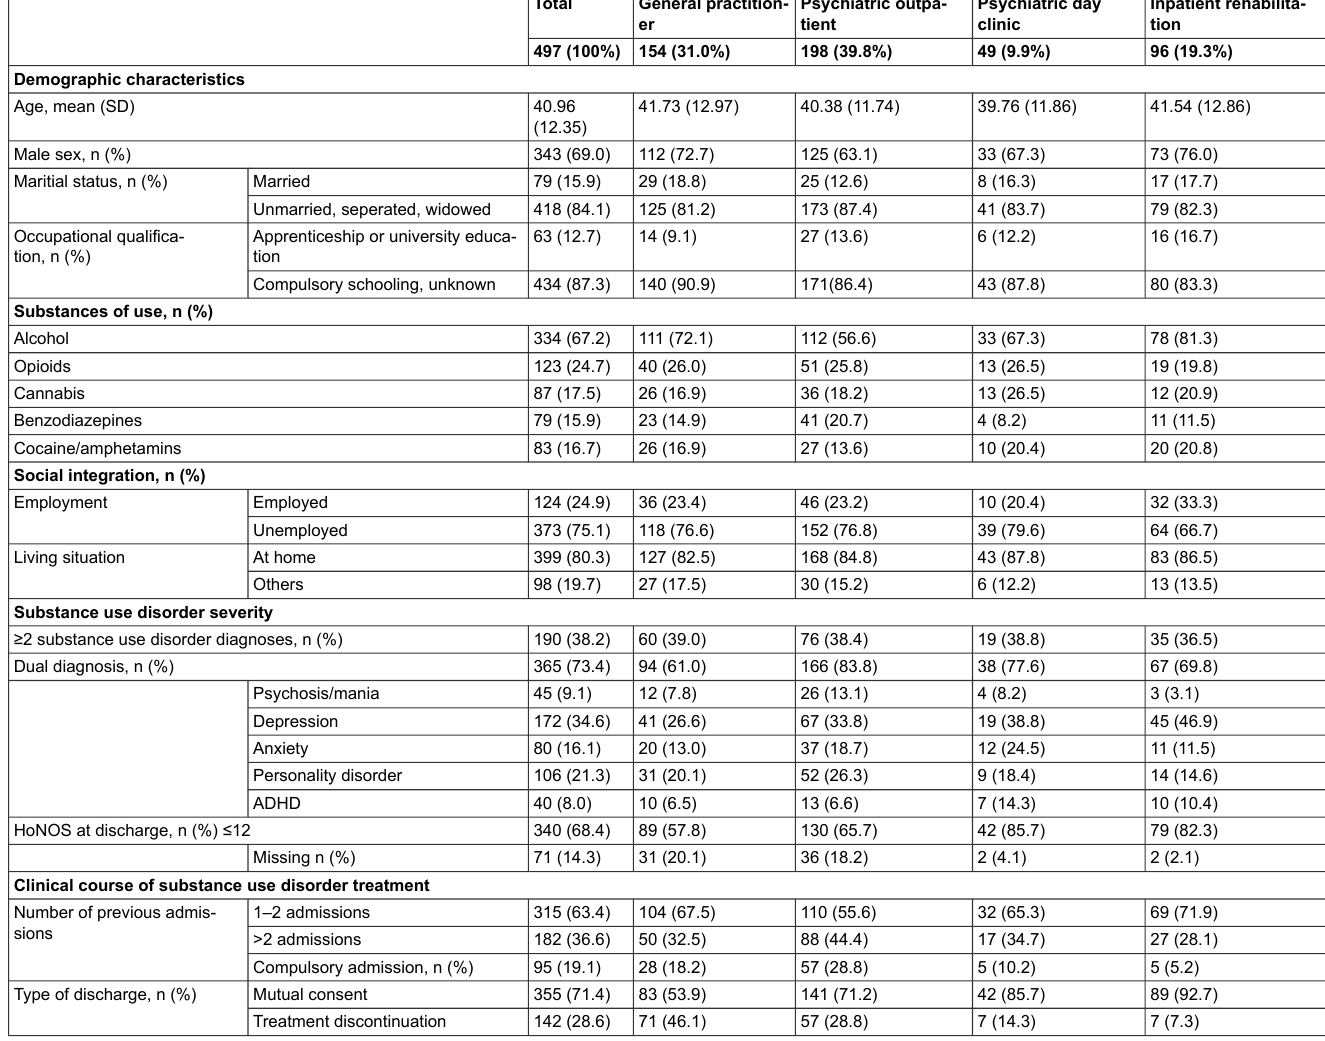
Table 1: Sociodemographic and clinical characteristics of the study